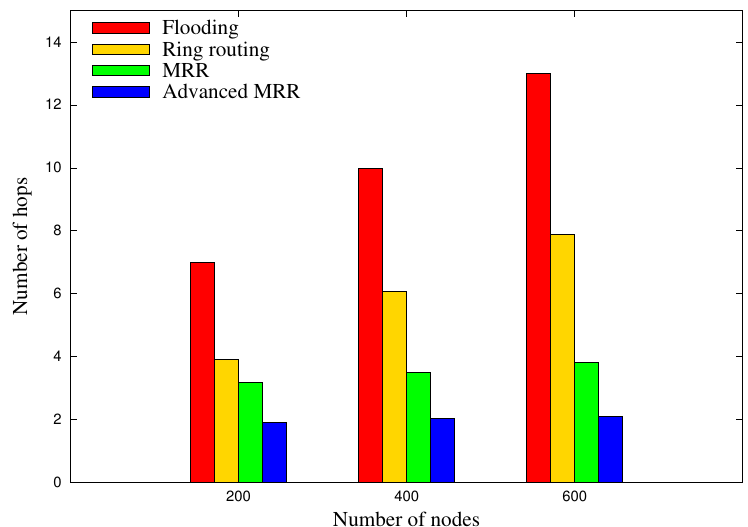
Figure 13. Number of hops required for each node to obtain the sink position for sending the data, which is the average value of 50 runs in each network size.